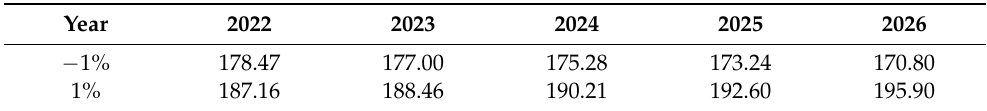
Table 16. Prediction result of water requirement with different growth rates of AVPI in